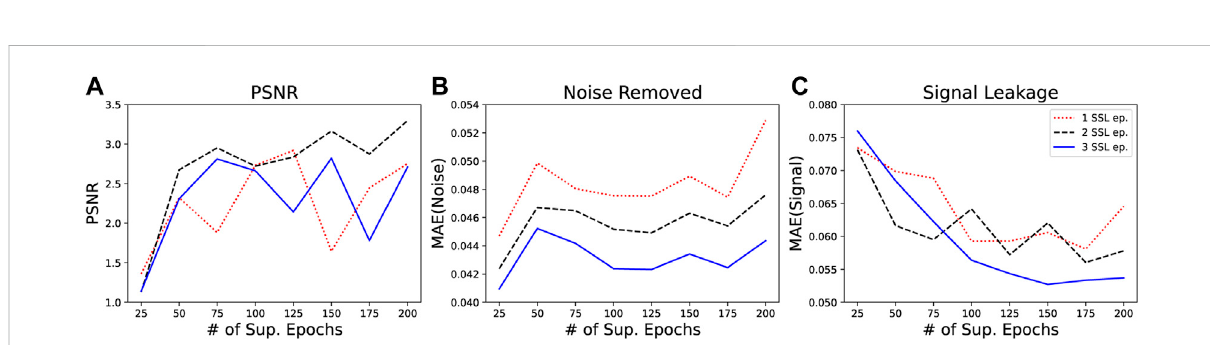
FIGURE 11 Comparison of denoising performance on the semi-synthetic dataset with respect to the number of supervised, base-training epochs. The performance is evaluated after one (red, dotted line), two (black, dashed line) and three (blue, solid line) self-supervised, fi ne-tuning epochs and considers the resulting (A) PSNR, (B) volume of noise removed, and (C) amount of signal leakage